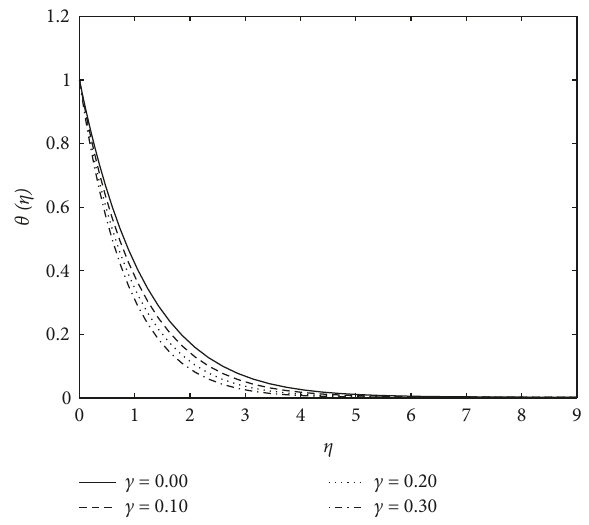
Figure 11: Change in the value of θ ( η ) for different values of c .